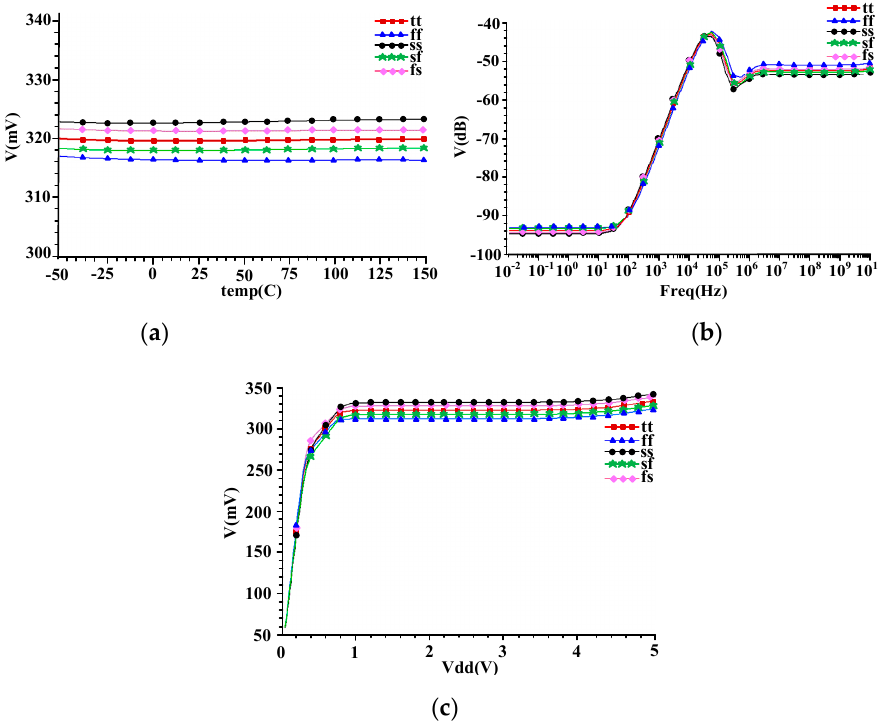
Figure 5. Simulation of Vref2 on different process corners: ( a ) simulation TC of Vref2 ; ( b ) simulation PSRR of Vref2 ; and ( c ) simulation LS of Vref2 .